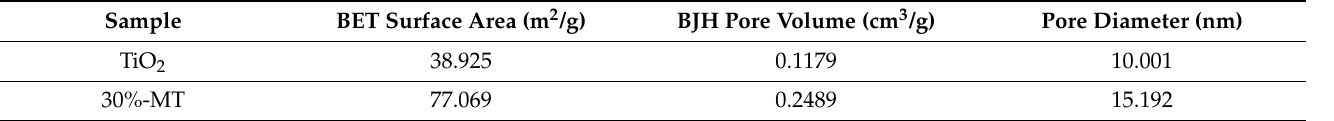
Table 3. BET parameters of TiO 2 and 30%-TM.